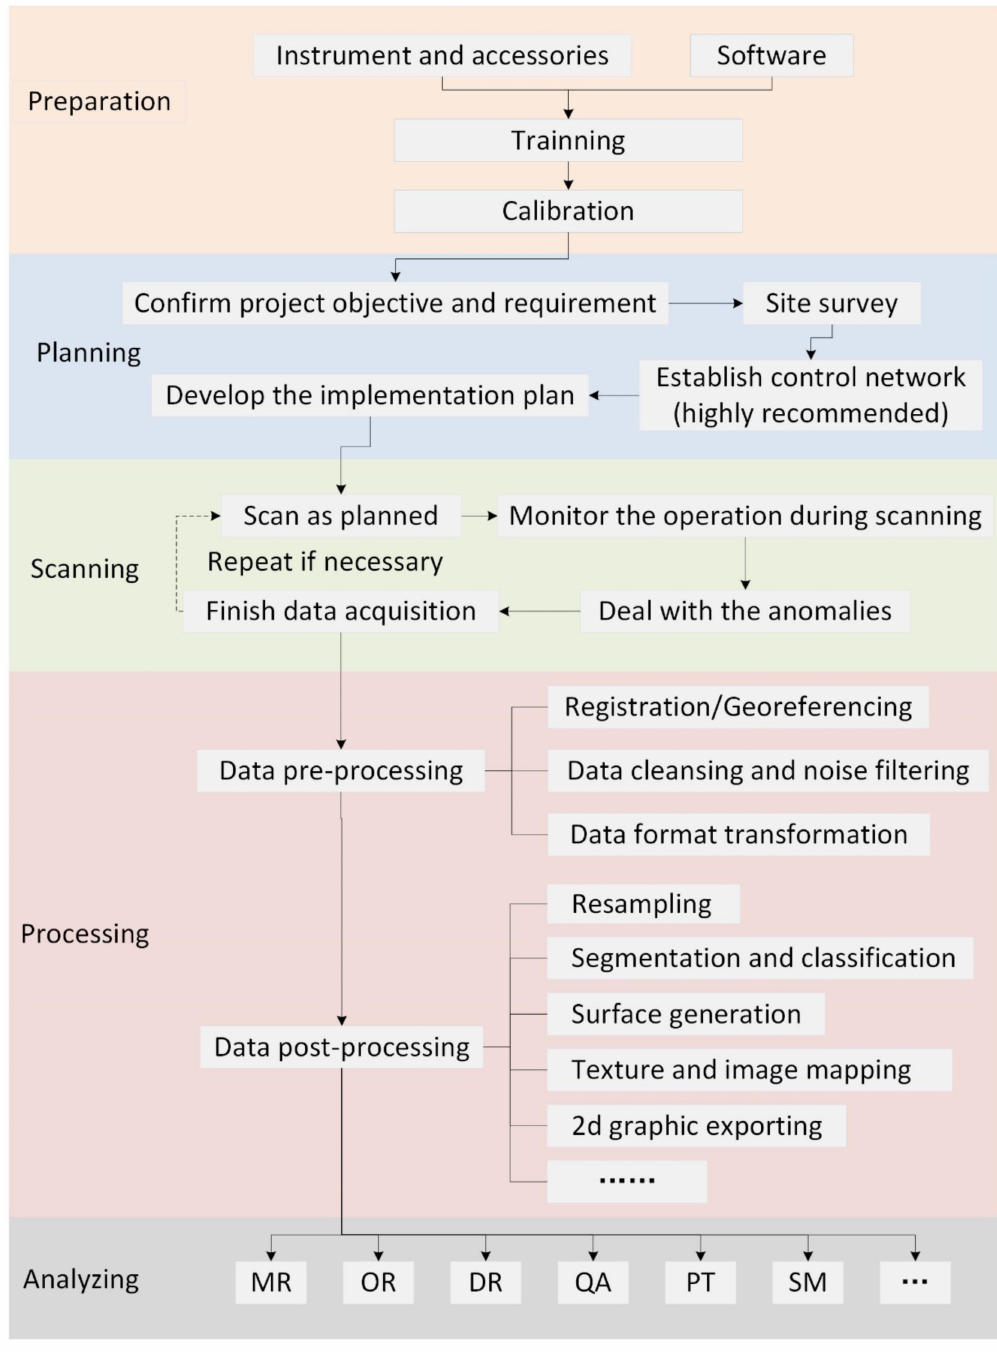
Figure 9. Workflow of